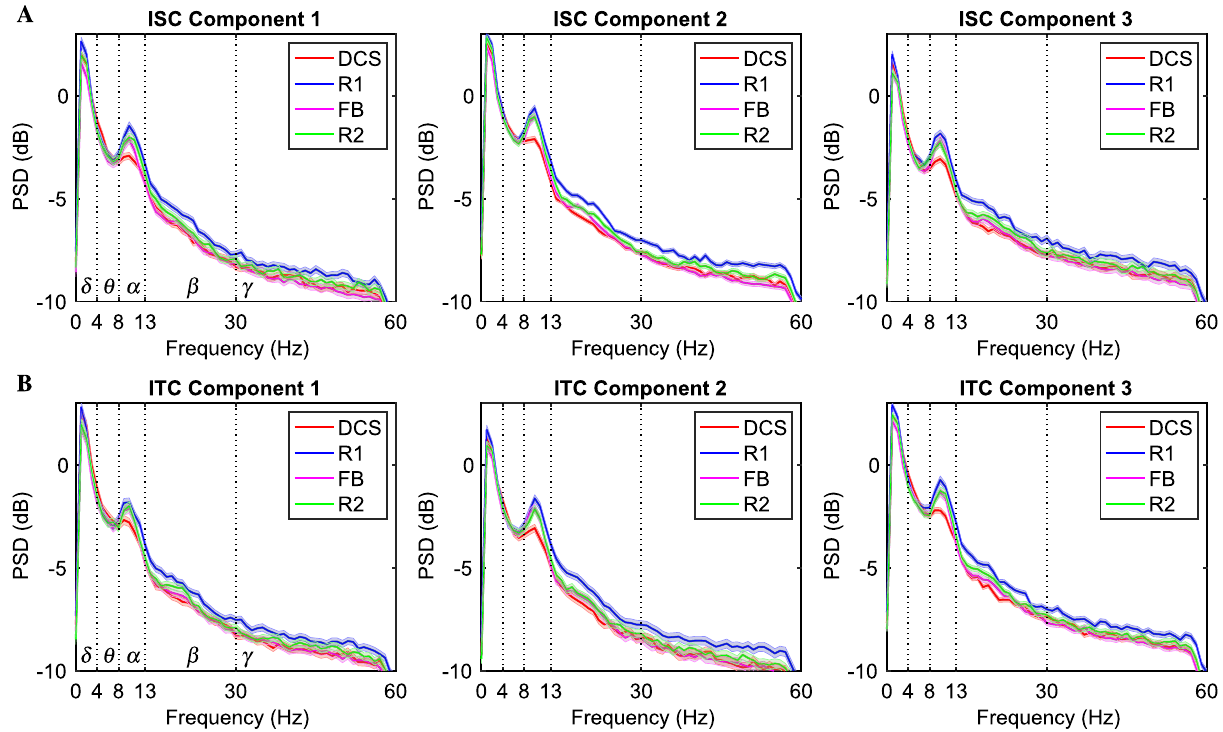
Figure 5. Averaged power spectral density (PSD) of 4 task periods (DCS (red), R1 (blue), FB (pink), and R2 (green)) for the first three ISC/ITC projection components calculated from all subjects of both LM and HM groups ( n = 23 ). Specifically, ( A ) depicts the PSDs of three ISC projection components, and ( B ) shows those of three ITC projection components. The shade of each curve indicated the standard error of the mean of each